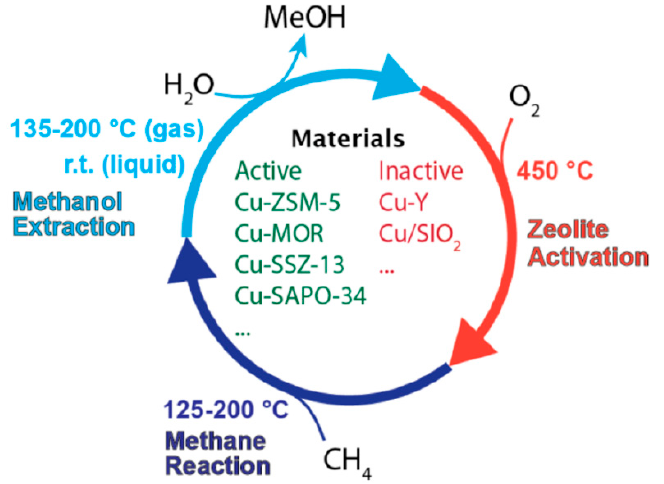
Figure 13. Scheme of stoichiometric chemical looping of CH 4 to CH 3 OH. Reproduced with permis- sion from [79]. Copyright 2017 American Chemical Society.